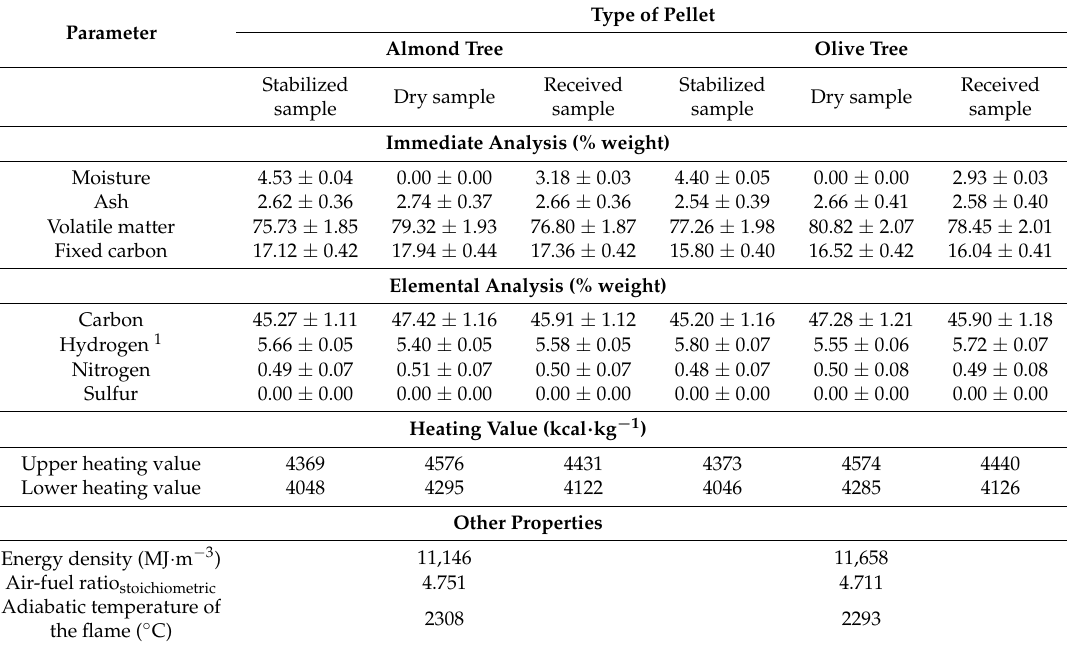
Table 2. Chemical characteristics of pellets from almond and olive